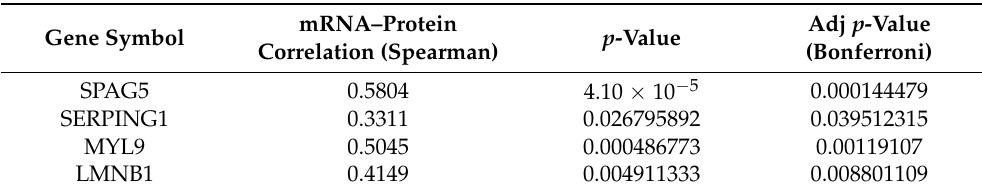
Table 2. Established RNA–Protein correlations (source https://www.breastcancerlandscape.org/, (accessed on 23 November 2021).